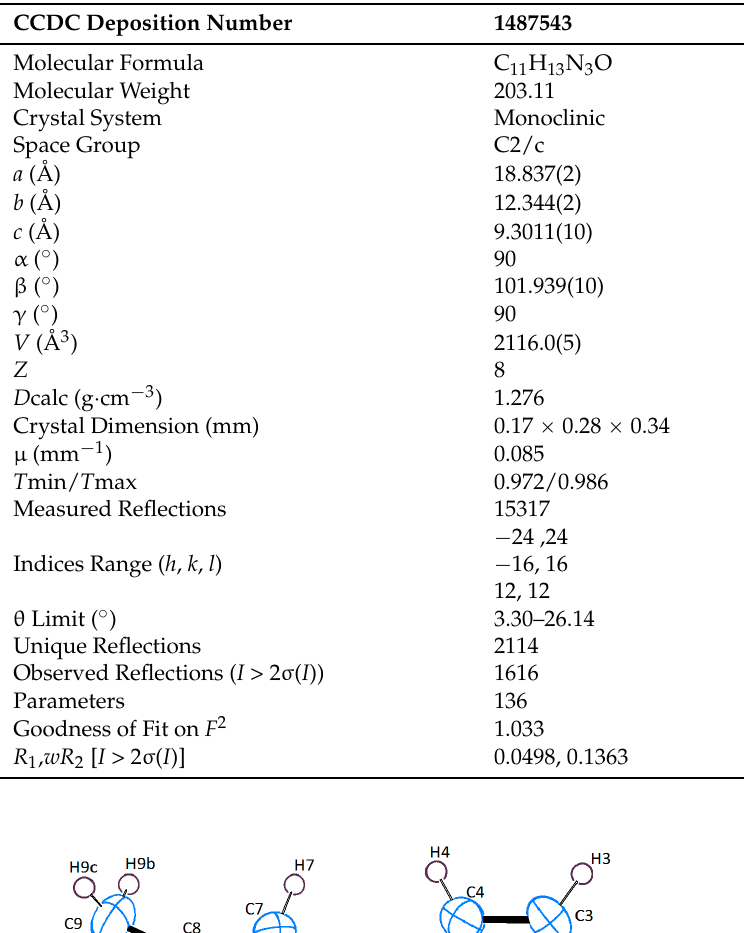
Table 1. Crystal data and refinement parameters for C 11 H 13 N 3 O.